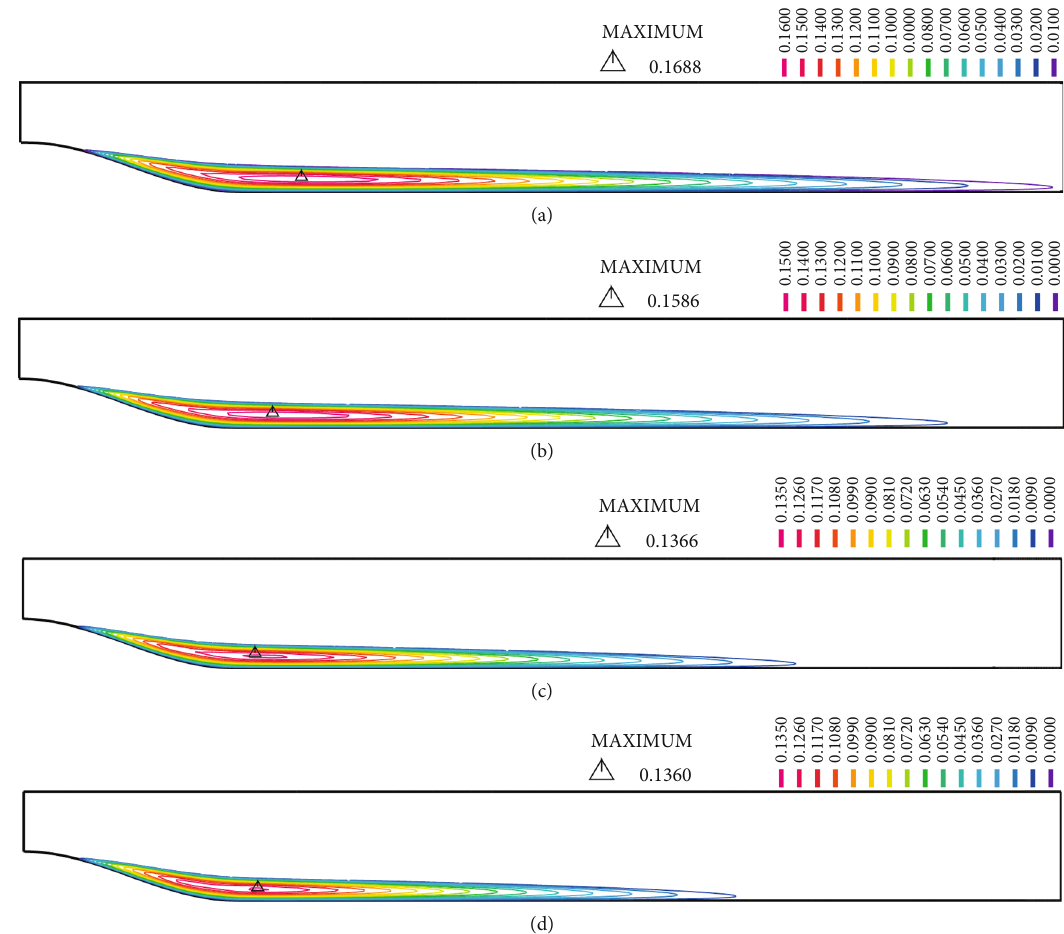
Figure 4: Reversal fl ow streamlines (m/s) at peak fl ow rate for 70% stenosis in (a) group 1 (b) group 2 (c) group 3 (d) group